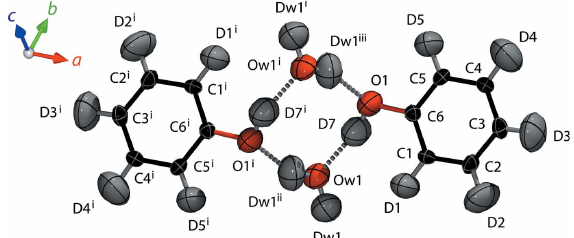
Figure 2 Phenol hemihydrate’s asymmetric unit (right) and the inversion-related atoms required to form the dimer (left); the inversion centre is located in the middle of the ring. Displacement ellipsoids are drawn at the 50% probability level. [Symmetry codes: (i) (cid:6) x , 1 (cid:6) y , 1 (cid:6) z ; (ii) (cid:6) x , y , 1 (iii) x , 1 (cid:6) y , 1